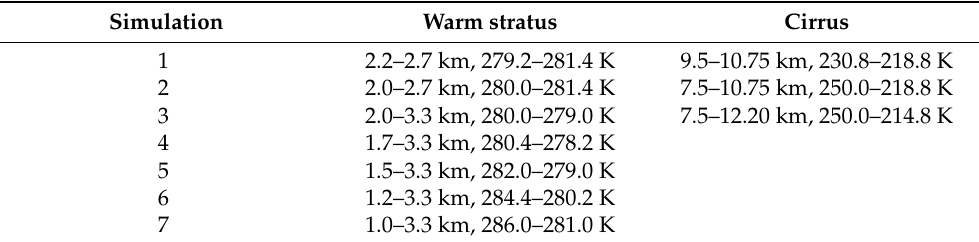
Table 1. Simulated clouds in an idealized COSMO version. Seven simulations of warm stratus of different widths and 3 simulations of cirrus of different widths were performed. For each experiment, the cloud heights and temperatures of cloud base and cloud top are mentioned,